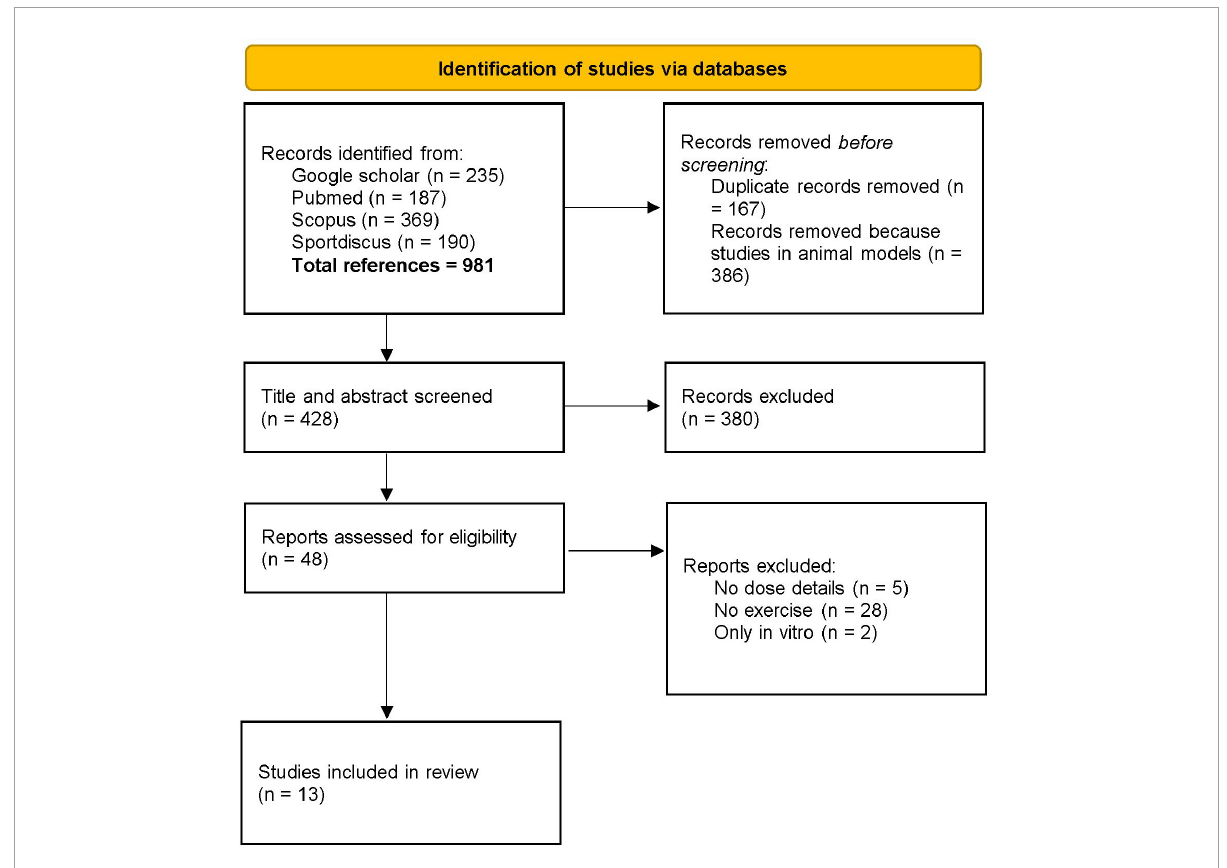
FIGURE1 Prisma flow diagram of the selection of the articles